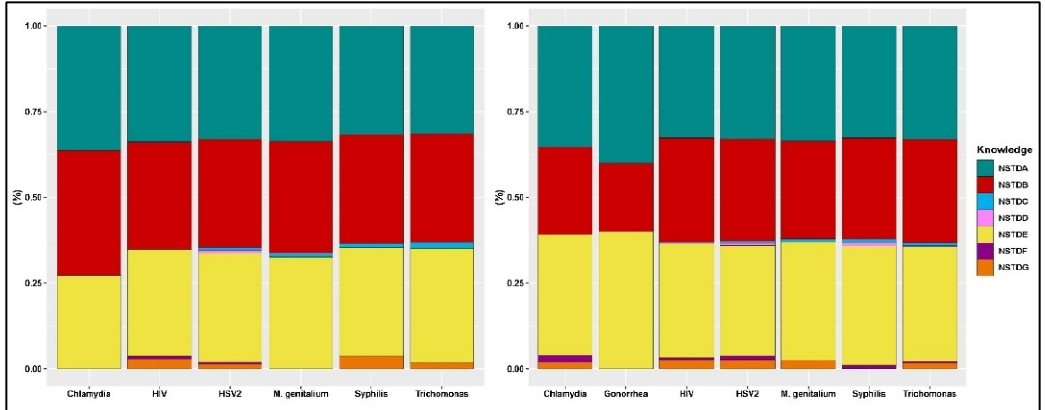
Figure 2. Prevalence of self-reported STI knowledge among men ( left ) and women ( right ) who tested positive for STIs. (NSTDA: Gonorrhea, NSTDB: Syphilis, NSTDC: Chlamydia, NSTDD: Genital Ulcers, NSTDE: AIDS, NSTDF: Herpes, NSTDG: Others).